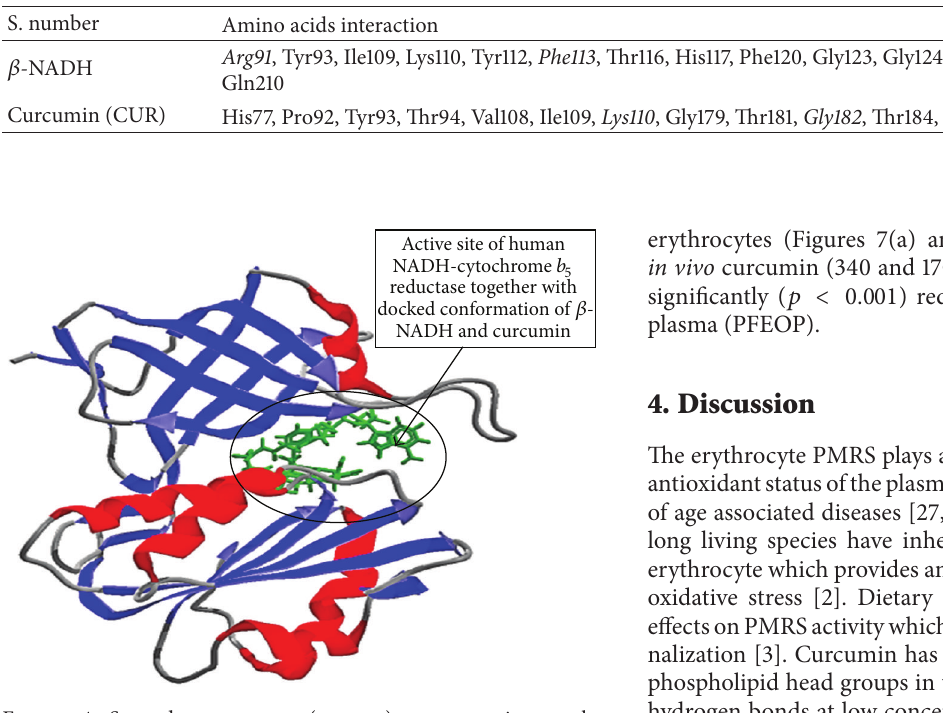
Figure 4: Secondary structure (cartoon) representation at the active site of human NADH-cytochrome 𝑏 5 reductase together with docked conformation of ligand 𝛽 -NADH and